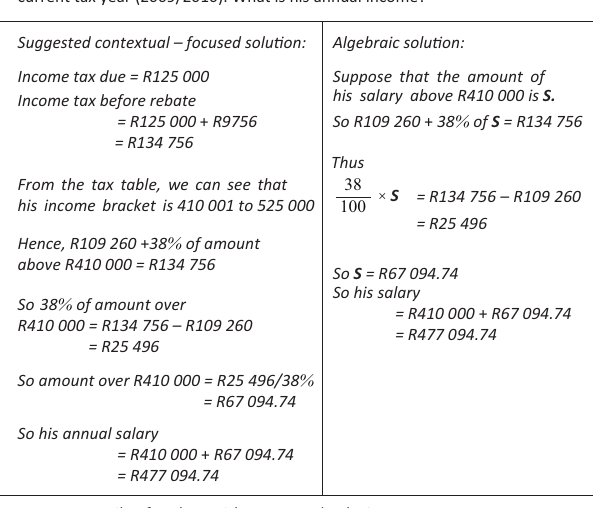
FIGURE 3: Details of Task 3, with suggested